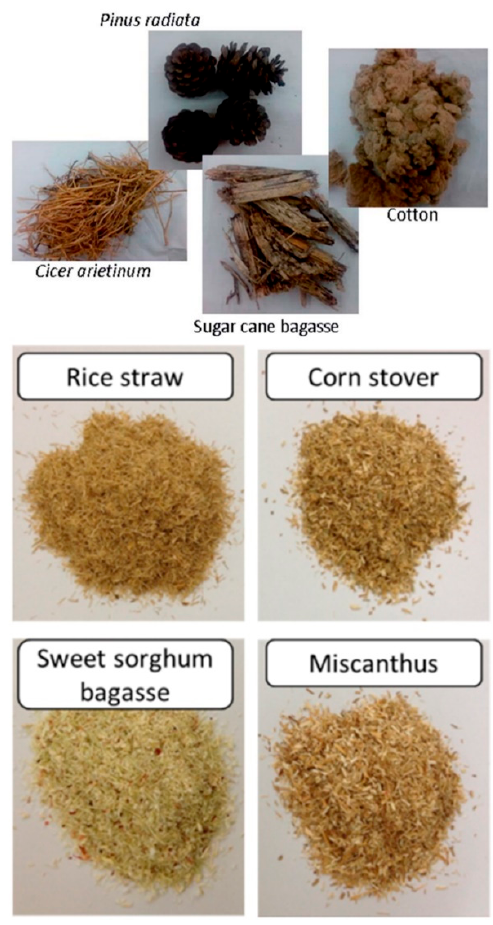
Figure 1. Diversity in cellulosic feedstock for levulinic acid production. Adapted with permission from ref. [63,70] .